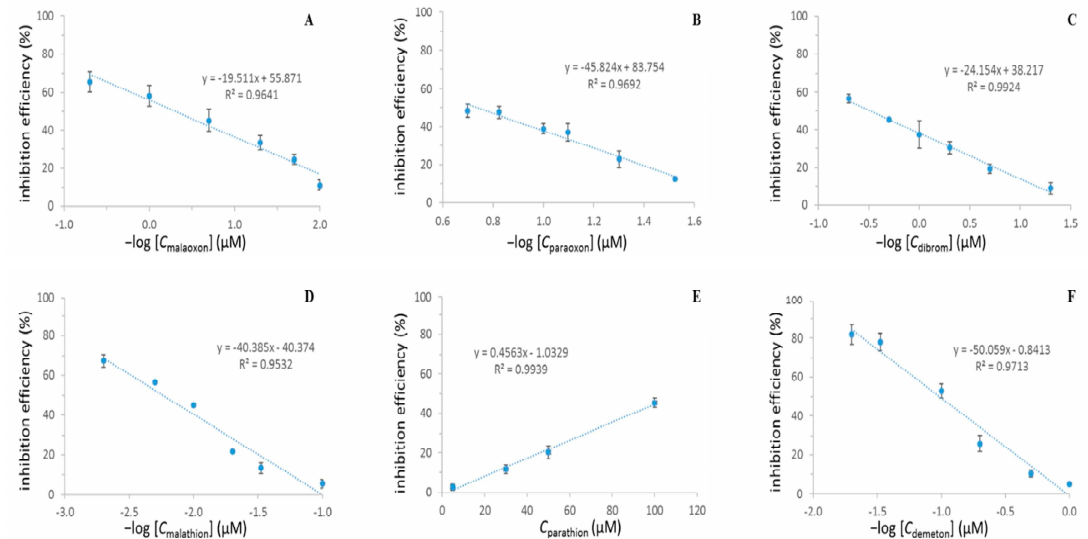
Figure 4. The plots of inhibition efficiency vs. the logarithm concentrations of malaoxon ( A ); paraoxon ( B ); dibrom ( C ); malathion ( D ) and demeton ( F ); and the plots of inhibition efficiency vs. the parathion ( E ) concentration. The concentrations of QDs, AChE and ChOx in all experiments were 2.5 nM, 40.8 U/mL and 637.5 U/mL, respectively.